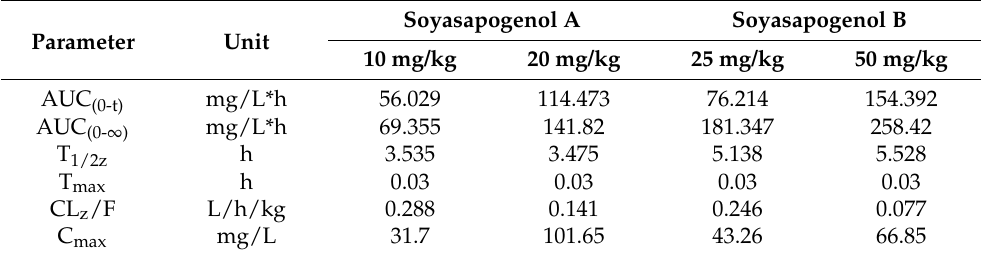
Table 2. Summary of pharmacokinetic parameter values (mean, n = 6) for soyasapogenols A and B after intravenous (I.V.) dose